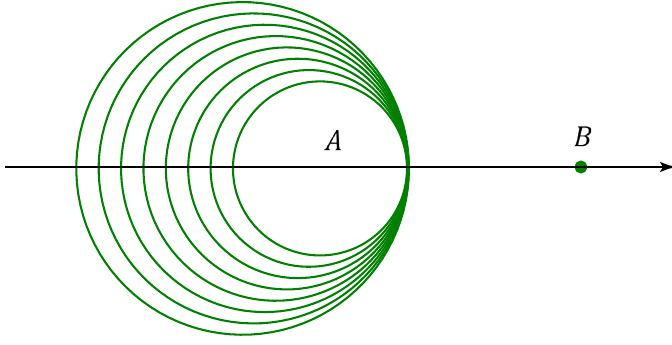
Figure 9 . The one-parameter χ family of invariant spheres in the OPE limit R B → 0